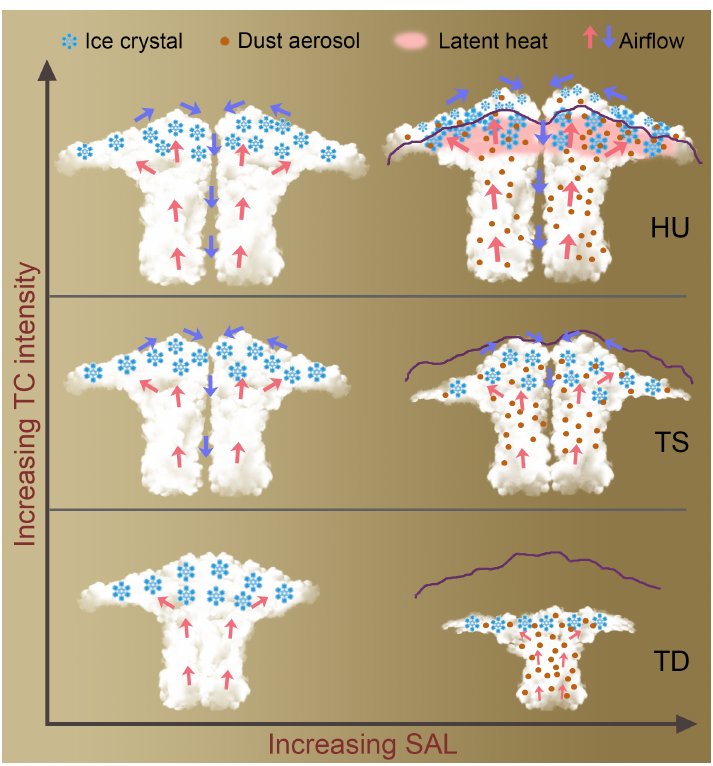
Figure 13. The scheme description of the effects of SAL on the TCCSs. The gradual desert color backdrop indicates the intensity of SAL. The purple curves are the cloud-top heights under pristine